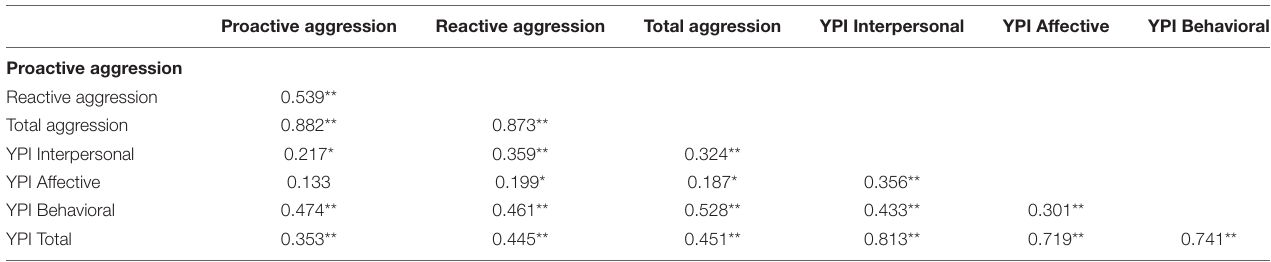
TABLE 2 | Correlations between measures of psychopathy and aggression (multi-problem group